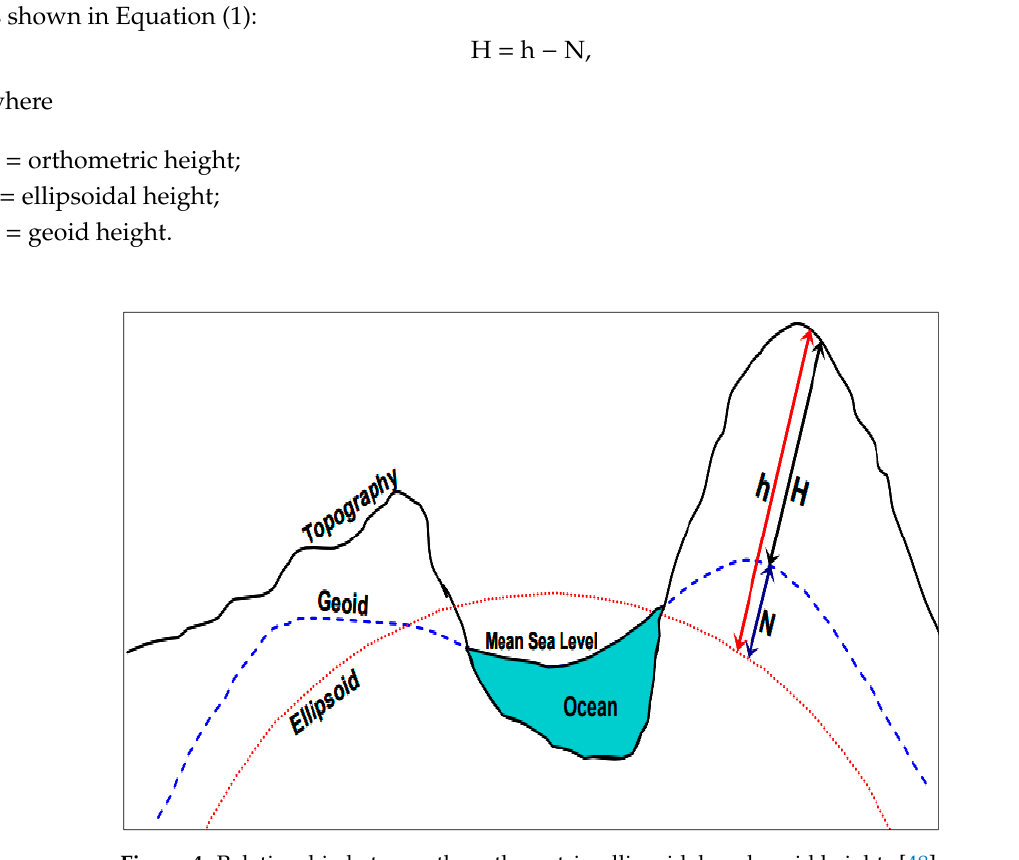
Figure 4. Relationship between the orthometric, ellipsoidal, and geoid heights [48]. Table 2. Details of GCPs at the study area.